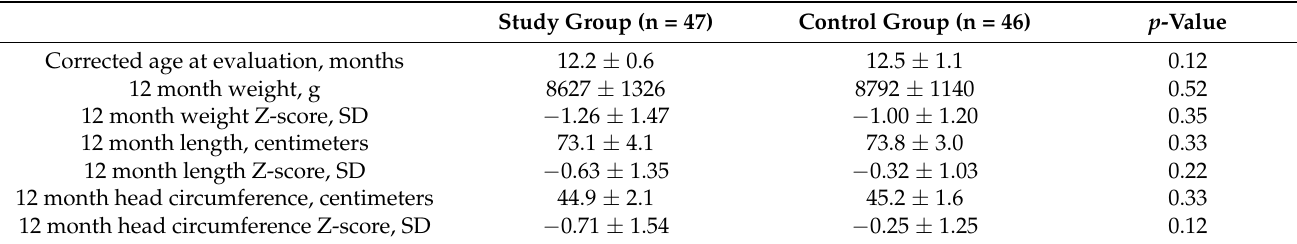
Table 2. Anthropometric evaluation in the two groups at 12 months CA.